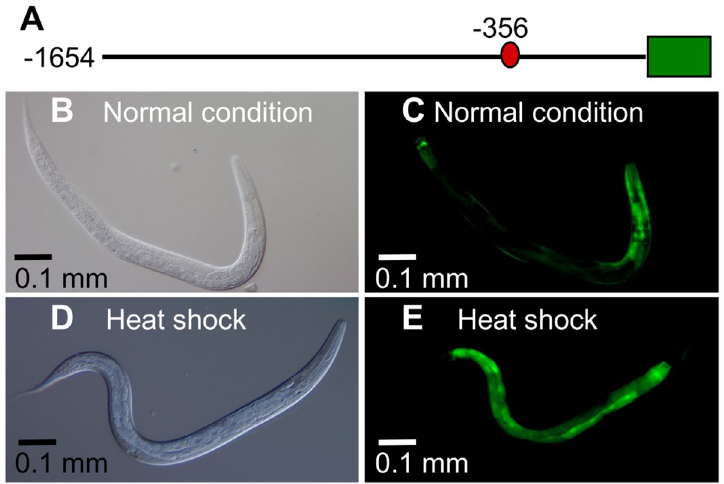
Fig 4. Heat shock alters Pegl-9 :: GFP expression. (A) The Pegl-9 :: GFP construct includes 1.6 kb of sequence 5’ to the egl-9 translational start. GFP coding sequence is diagramed as a green box. The red oval indicates the position of the putative SKN-1 binding site. (B-E) Pegl-9 :: GFP expression in L4-stage animals under normal culture conditions and heat shock. Animals are shown as DIC images (B and D) and corresponding images of GFP fluorescence (C and E). In all images, the head is to the right. (B and C) Under normal conditions, Pegl-9 :: GFP was expressed in the body muscle, vulva, pharynx, anterior intestine, rectal cells and additional cells in the tail. (D and E) After heat shock treatment (29˚C for 20 hours), Pegl-9 :: GFP was strongly induced in the intestine. The Pegl-9 :: GFP expression patterns in the L1, L2, L3 and adults were similar to that in the L4 worms, under both normal and heat shock conditions (S2 Fig).